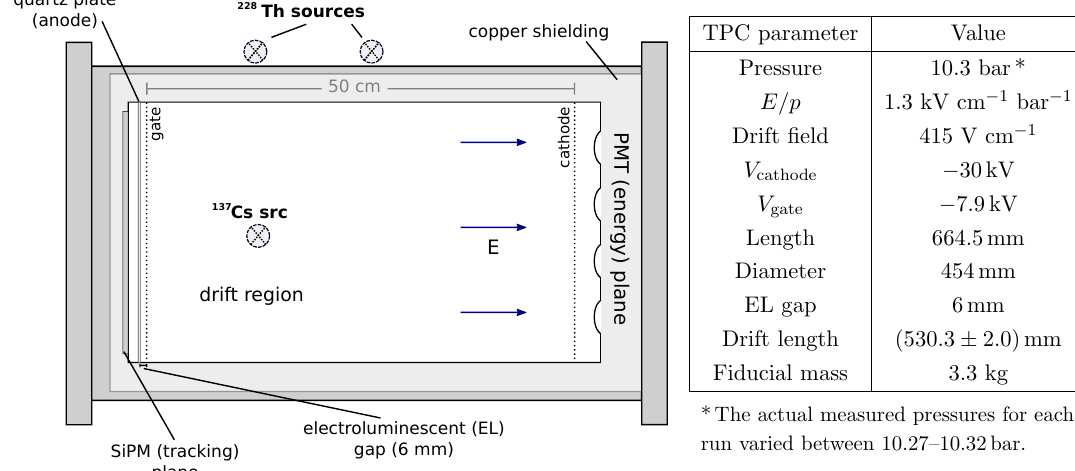
Figure 1 . Experimental summary. (Left) Schematic of the main components of the NEXT-White TPC and locations of the calibration sources (not drawn to scale). 137 Cs and 228 Th sources were placed in the lateral and top entrance ports of the pressure vessel, respectively, and a second 228 Th source (the leftmost of the two) was placed directly on top of the vessel. (Right) Operational parameters used in the present